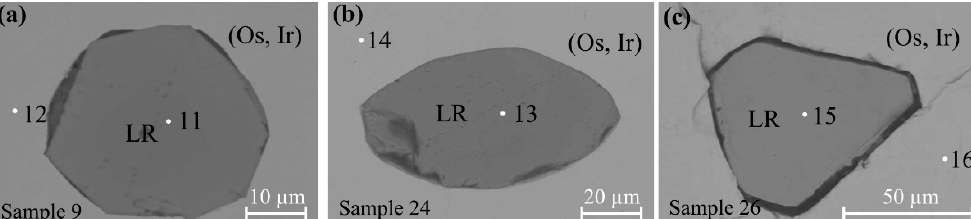
Figure 5. X-ray maps of high-Mg olivine inclusion in laurite (sample 164). ( a )—MgK α , ( b )—FeK α , ( c )—SiK α , ( d )—RuL α , ( e )—SK α .